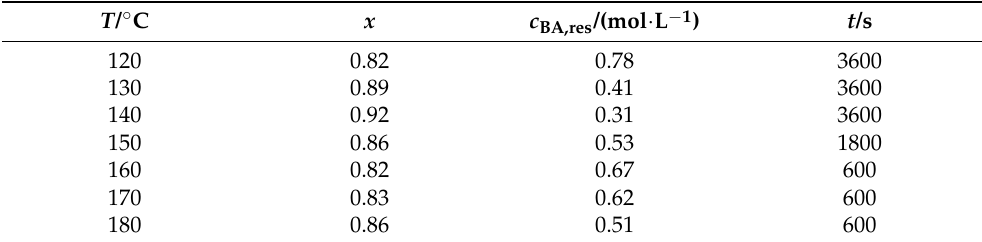
Figure 5. Conversion (black) and c BA (red) derived from NIR spectra for a polymerization in dioxane at 150 ◦ C with an initial BA concentration of 3.69 mol · L − 1 . Table 2. Monomer conversion, x , and residual BA concentration, c BA,res , determined for BA polymerizations in dioxane with c BA,0 =3.69 mol·L –1 at the given temperatures, T , and reaction times, t. T /°C